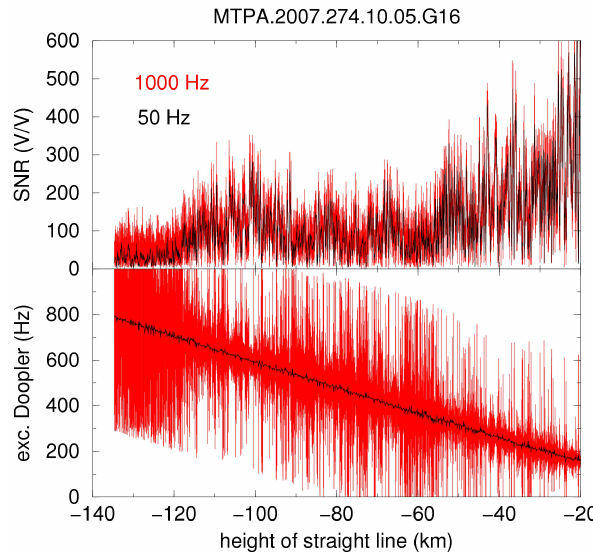
Fig. 6. Amplitude (upper panel) and Excess Doppler (lower panel) of Metop/GRAS raw sampled signal at 1000Hz (red line) and down-sampled to 50Hz (black